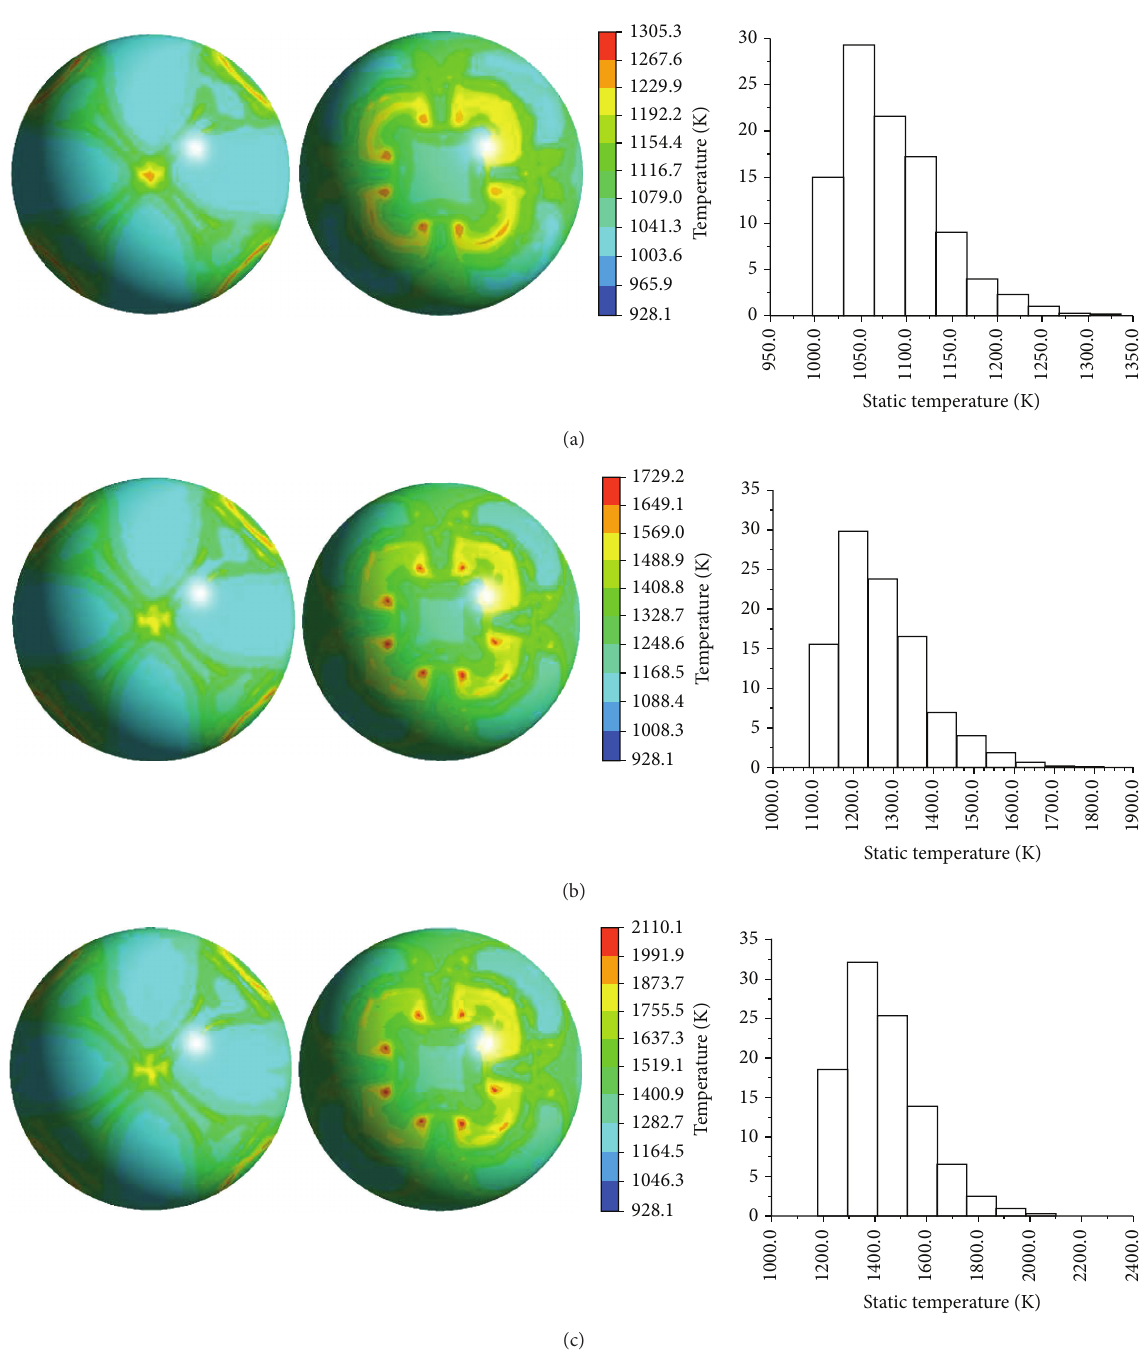
Figure 9: Pebble temperature distribution of BCC model of Cases 2a, 2b, and 2c (view from inlet (left), outlet (middle)) and temperature distribution